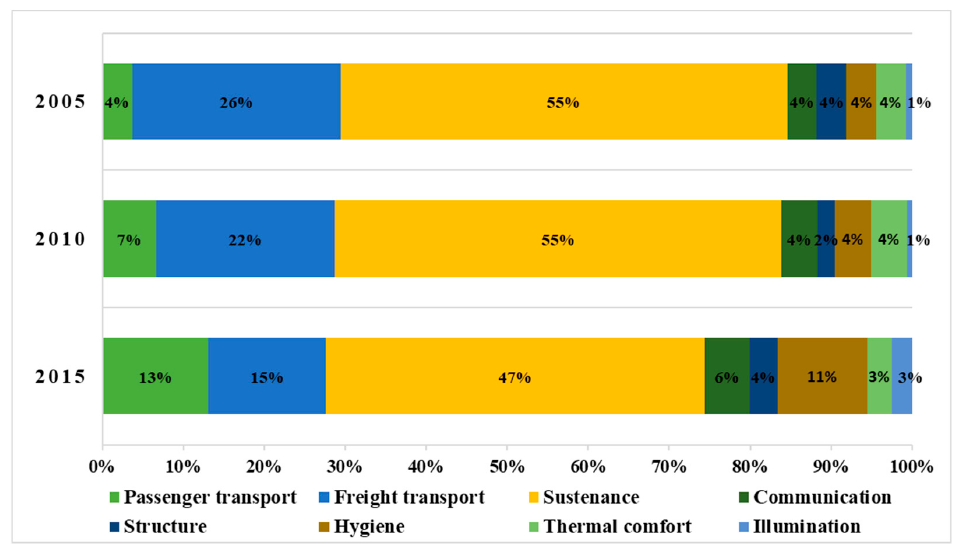
Figure 12. The share of exergy delivered to final services in China from 2005 to 2015.